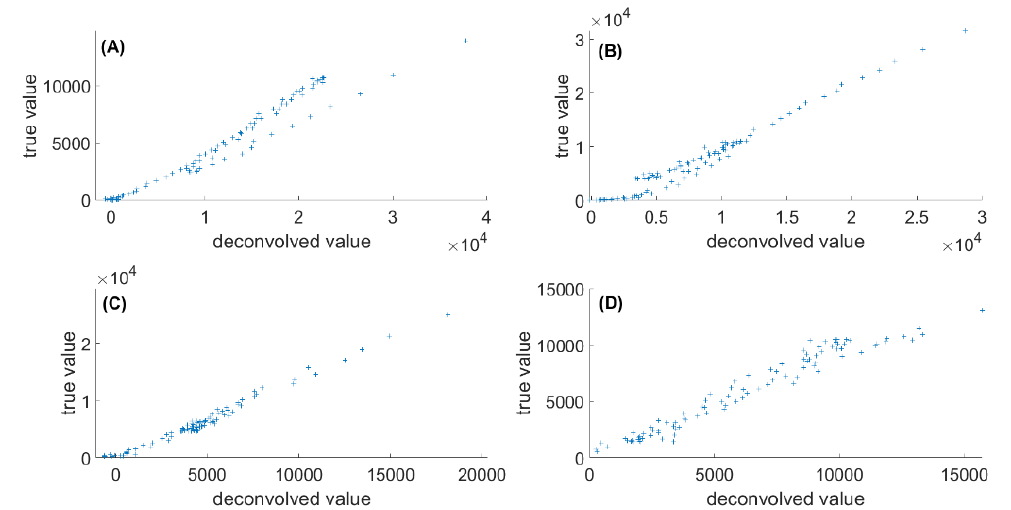
Figure 2. D1nh experimental data (black crosses), fitted signals (red lines) and deconvolved components using the iterative multivariate peak fitting approach: ( A.I , B.I , C.I ) first-order data (mean profile) fitted with a Gaussian, PMG1 and PMG2 mathematical functions. ( A.II , B.II , C.II ) second-order data fitted with a Gaussian, PMG1 and PMG2 mathematical func- tions.